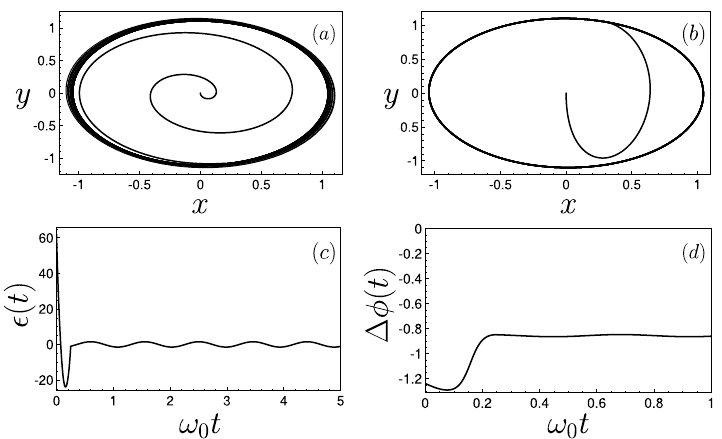
Figure 1. Speed-up of classical synchronization. ( a ): System trajectory in the ( x , y ) plane under a sudden sinusoidal driving. ( b ) System trajectory under a shortcut+sinusoidal driving ε( t ) . ( c ) Profile of the driving amplitude ε( t ) . ( d ) Phase difference between the shortcut-driven system and the sinusoidal drive phase �φ = φ( t ) − ω t − ϕ . ([ π ]). Parameters used: ω = 1.05 × ω 0 , ε 0 = 1.5 / T 0 , κ 1 = 1 / T 0 , κ 2 = 0.5 / T 0 and times τ = T 0 / 4 and t ∞ = ( 50 + 1 / 8 ) T 0 , where T 0 is the free oscillator